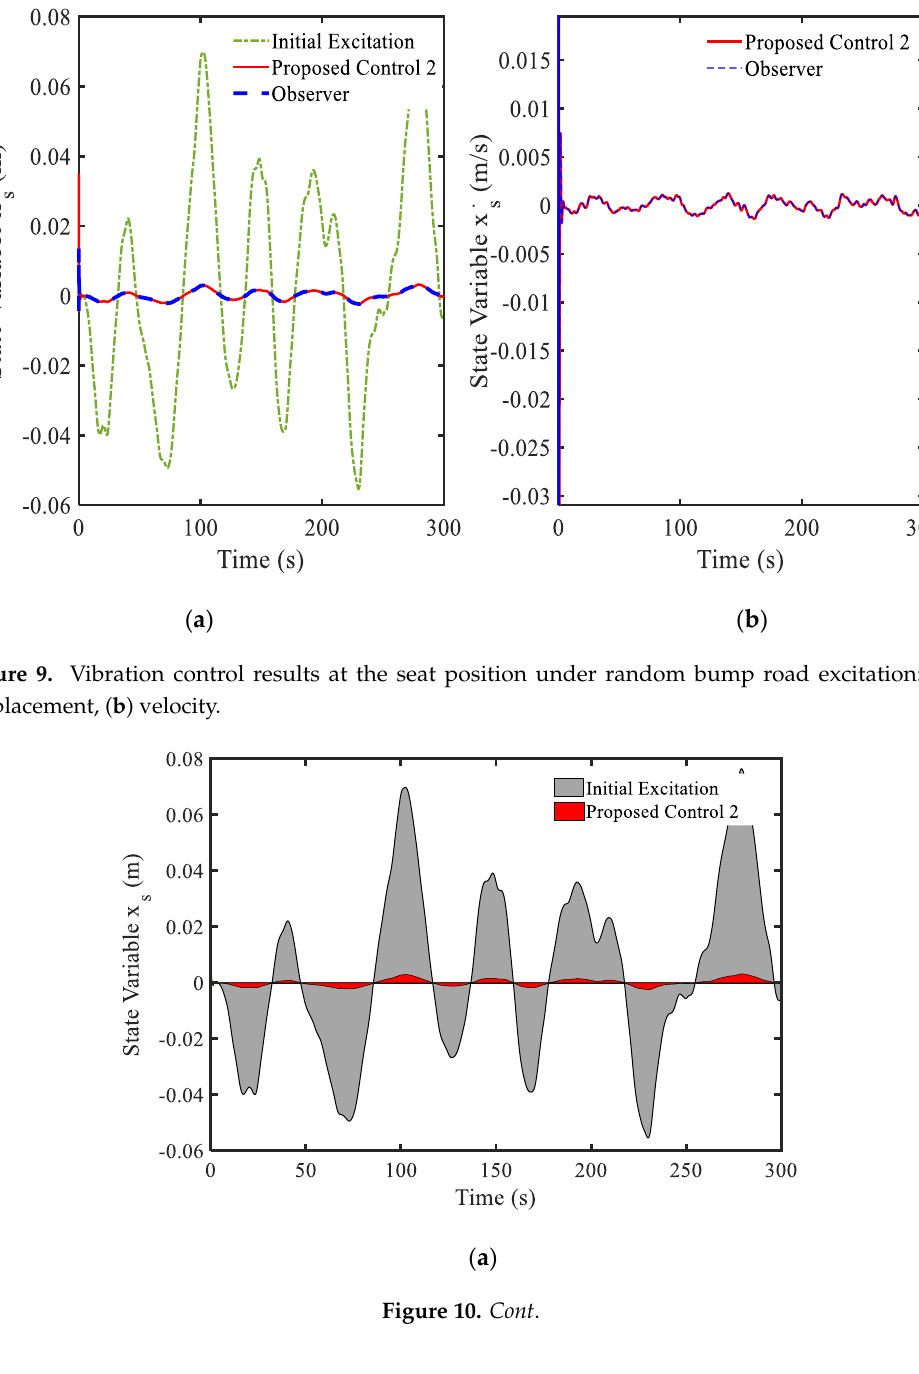
Figure 8. Control results under random bump road excitation: ( a ) gain function